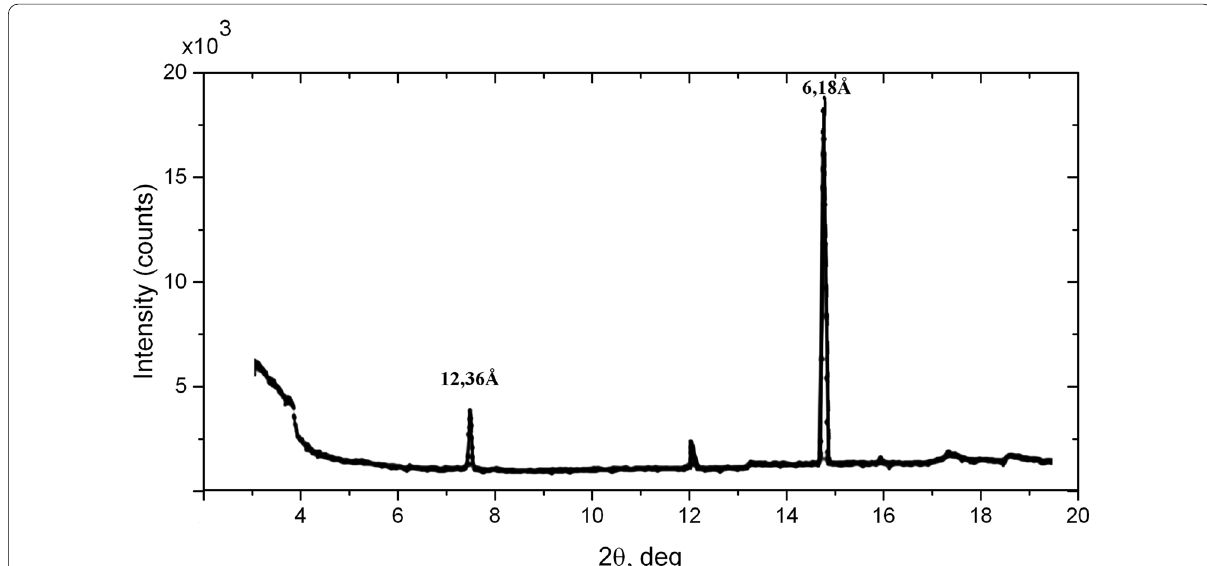
Fig. 3 X-ray synchrotron diffraction pattern (ID01, ESRF) taken from the middle part of the narrow BDD plate. The most intense reflections correspond to the distances between boron–carbon layers 12.36 and 6.18 Å . Low-intensity reflections originate from islands with other periods (not indexed). In particular, the peak at 2 θ 12.2° can be assigned as fifth order from islands with period equal to ~ 37.08 =